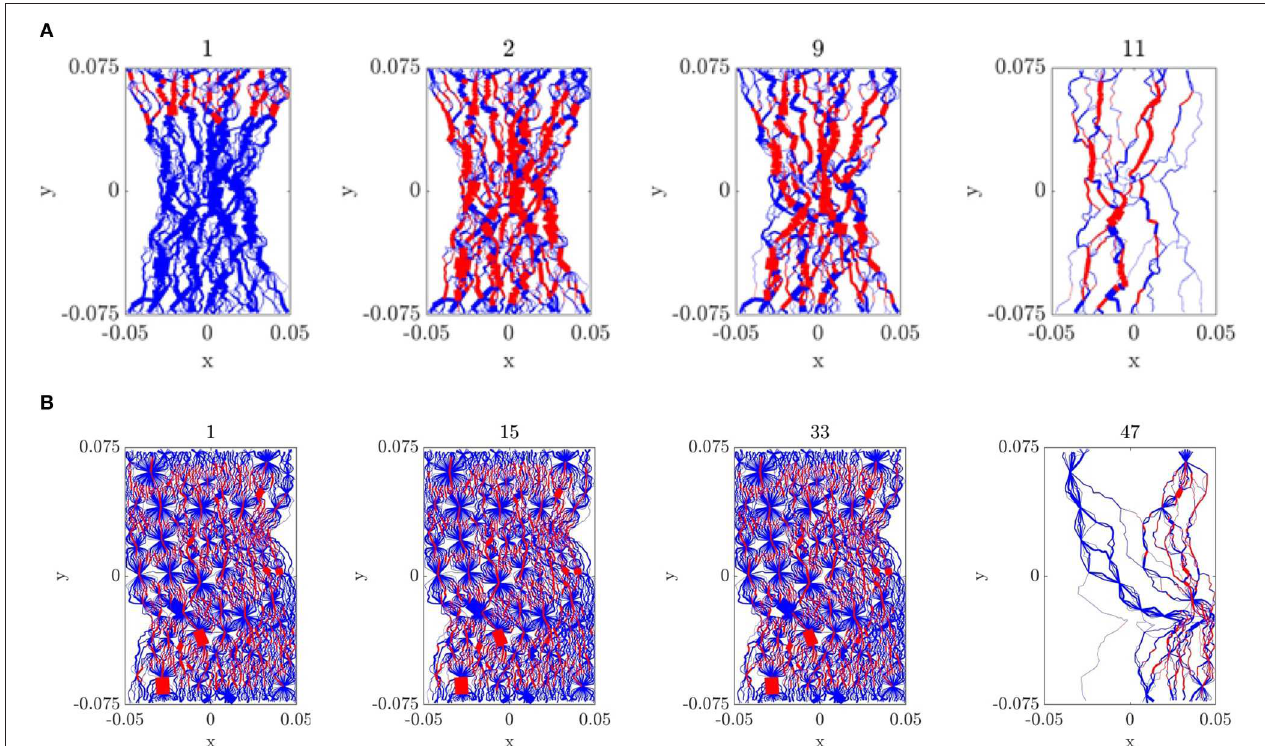
FIGURE 9 | (Color online) System-spanning preferential paths for force transmission P . (A) DI and (B) DII. Link thickness is proportional to the force flow across each link: between grains in tensile force chains (red) or otherwise (blue). Note percolating tensile force chains are first established at stage 2 in DI ( Figure S1 ).